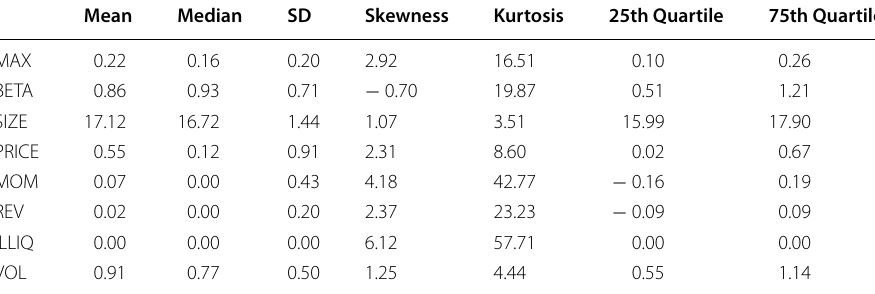
Table 1 Descriptive statistics of the main